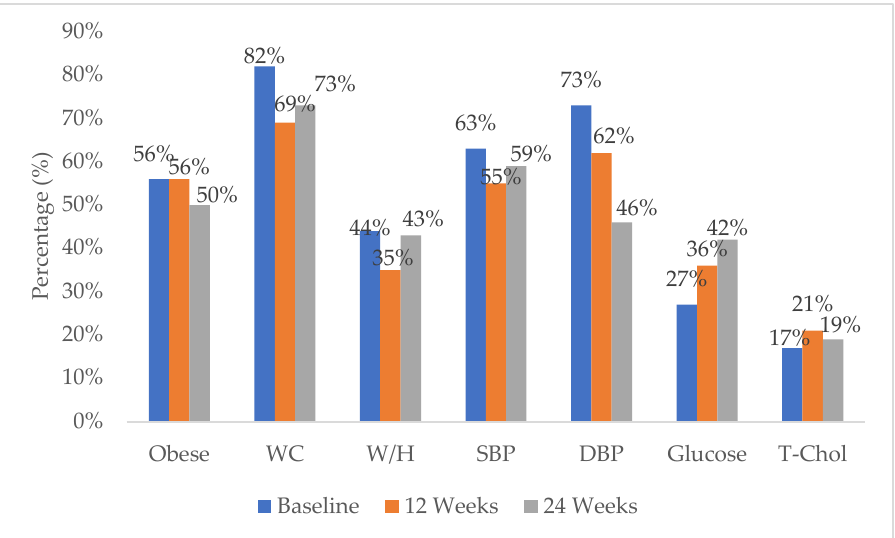
Figure 2. The percentage of participants presenting with non-communicable disease risk factors at baseline, 12 weeks, and 24 weeks of exercise intervention. Note. WC = waist circumference, W/H = waist-to-hip ratio, SBP = systolic blood pressure, DBP = diastolic blood pressure, and T-chol = total blood cholesterol.